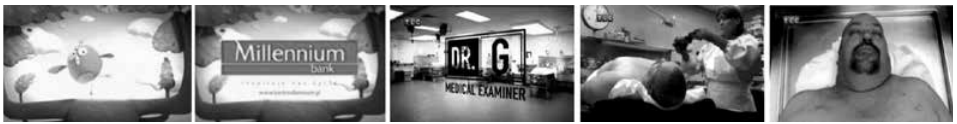
Figure 2(b). Incongruent and controversial 2: vignette (bank) attached to autopsy